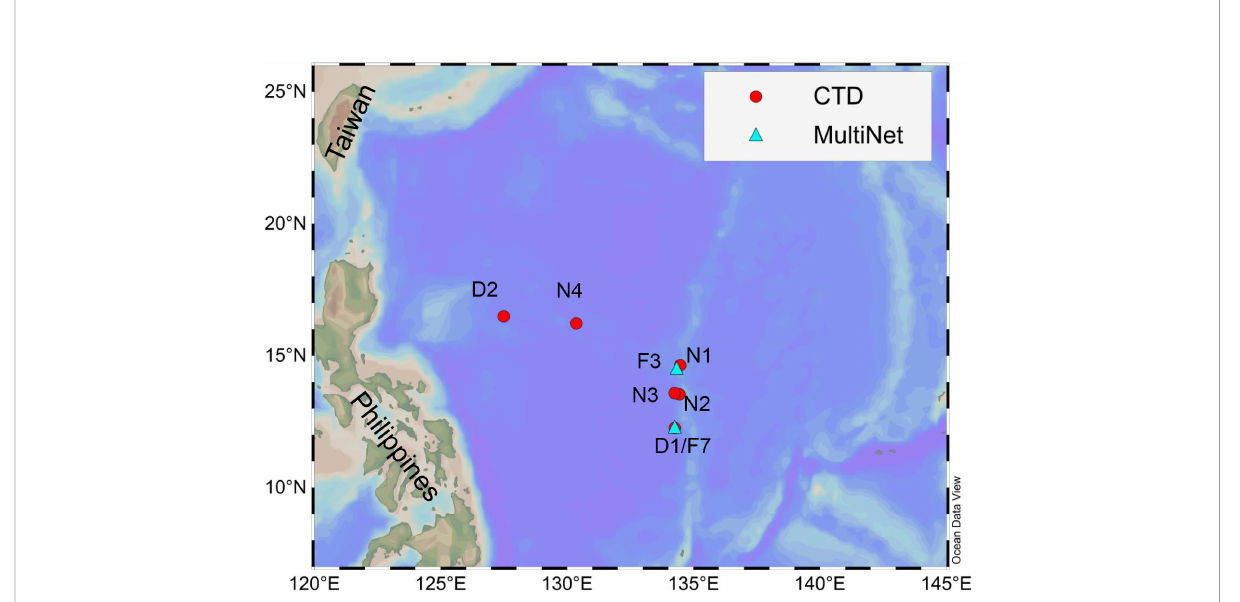
FIGURE 1 Position of the six CTD casts (red circles) and two MultiNet tows (blue triangles) in the western tropical Paci fi c